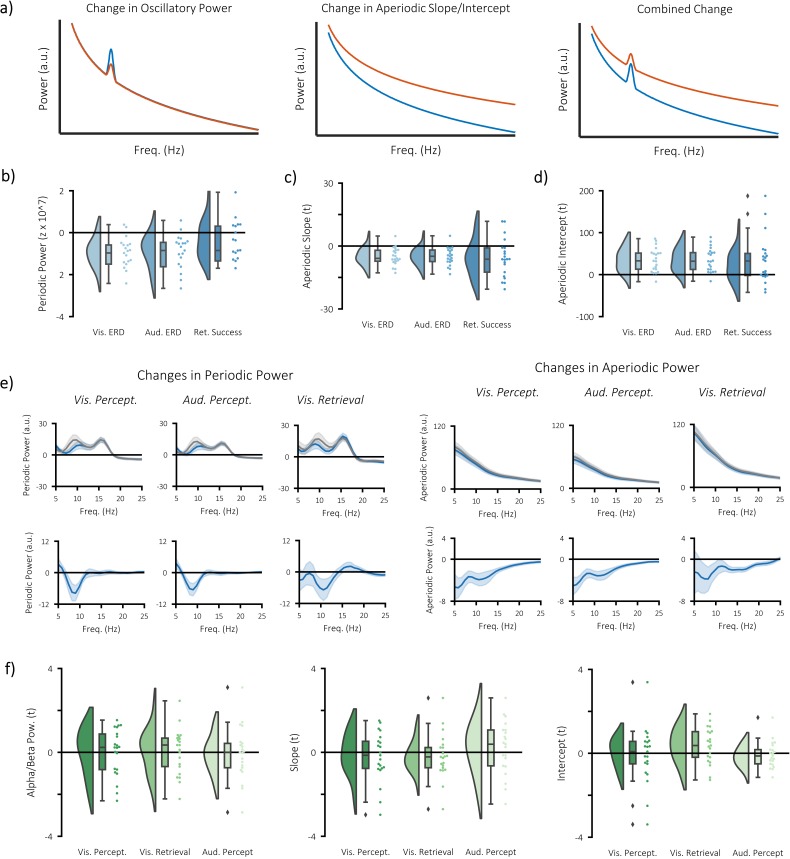
Separate contributions of periodic and aperiodic signal to event-related decreases in power.(a) wavelet-based time-frequency analytical approaches can detect changes in power that are oscillatory (left), aperiodic (middle), or a combination of the two (right). As a consequence, it becomes difficult to infer what a change in power reflects on a neural level. Methods such as the irregular-resampling auto-spectral analysis (IRASA) separates the power spectrum into periodic components (which reflects oscillatory activity) and aperiodic components (which reflect dynamics of the 1/.f phenomenon). By separating these components, we can identify whether changes in power are a result of changes in oscillatory activity or the 1/f characteristic. (b) significant decreases in periodic alpha/beta power (8–25 Hz) were observed during visual perception (p<0.001, Cohen’s dz = 0.55), auditory perception (p<0.001, Cohen’s dz = 0.46), and visual memory retrieval (p<0.001, Cohen’s dz = 0.48). (c) significant decreases in the slope of the aperiodic signal (i.e. a flattening of the 1/f curve) were observed during visual perception (p=0.002, Cohen’s dz = 0.68), auditory perception (p=0.011, Cohen’s dz = 0.67), but not during visual memory retrieval (p=0.123, Cohen’s dz = 0.52). (d) significant increases in the intercept of the aperiodic signal were observed during visual perception (p=0.002, Cohen’s dz = 0.73) and auditory perception (p=0.049, Cohen’s dz = 0.61), but not during visual memory retrieval (p=0.356, Cohen’s dz = 0.54). (e) frequency spectra for periodic (left) and aperiodic (right) signals. Plots on the top compare post-stimulus (blue) power with pre-stimulus (grey) power during visual/auditory perception and hits (blue) with misses (grey) during visual retrieval. Plots on the bottom depict the difference between the blue and the grey bars. Note that the ~16 Hz peak in the oscillatory signal is mostly likely produced by the MRI scanner, which collected a new slice 16 times a second. The peak could not be filtered out as done so with the wavelet data because the filtering impairs the fractal fit. (f) correlation between stimulus-specific information and periodic (left) and aperiodic (middle/right) measures of power. No significant relationship was observed in any of the measures or any of the tasks.